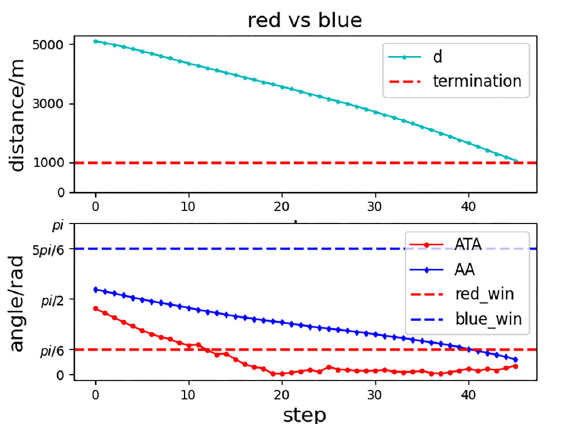
Figure 11. The changes of ATA , AA and d in the later training period in case 1.